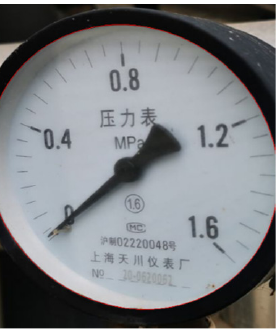
Figure 6. Perspective transformation results.